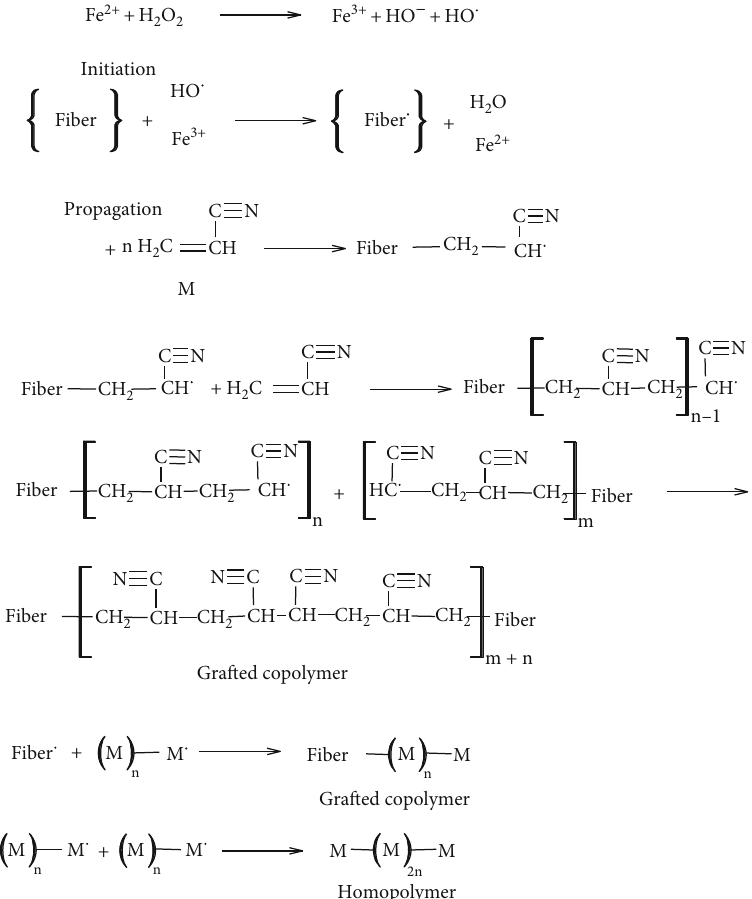
Figure 1: Mechanism of graft copolymerization of acrylonitrile onto